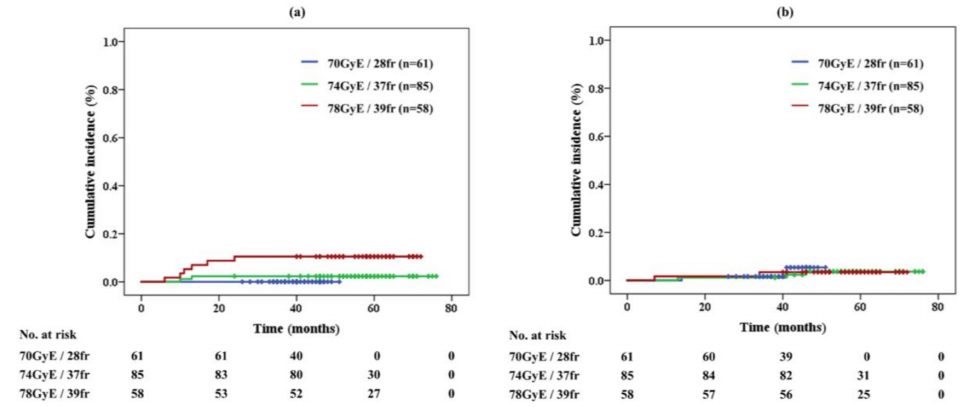
Figure 2. ( a ) Late gastrointestinal toxicity and ( b ) genitourinary toxicity of proton beam therapy alone in each